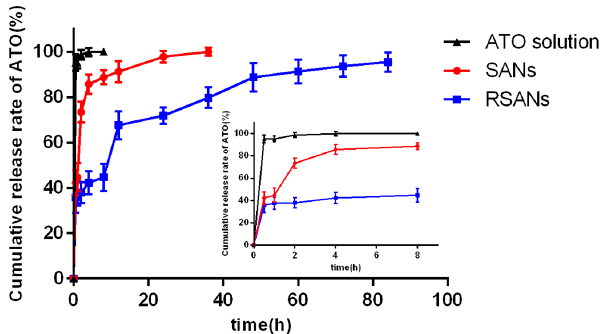
Figure 4. In vitro release curve of ATO, SANs and RSANs at 37 °C for 84 h. Data are shown as ± SD of the mean ( n = 3).